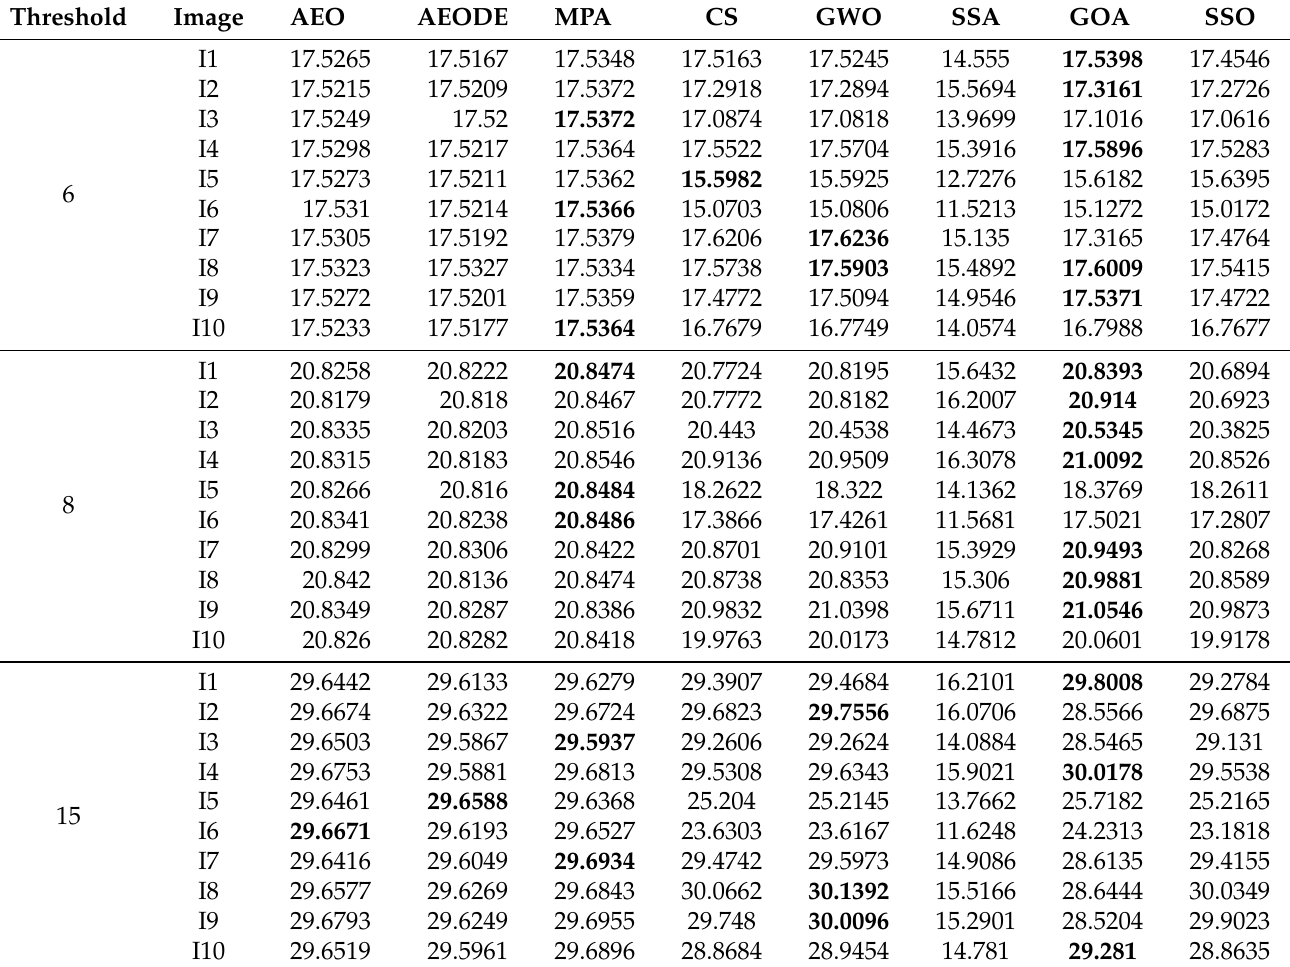
Figure 7. Fitness values of AEODE and other optimization algorithms. Table 3. Fitness function results for all algorithms (bold means the best